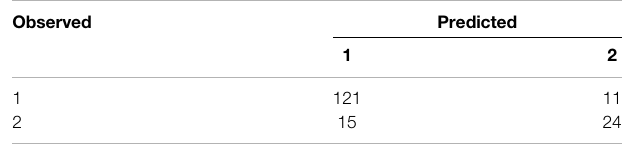
TABLE 6 | Signi fi cance of the variables for the